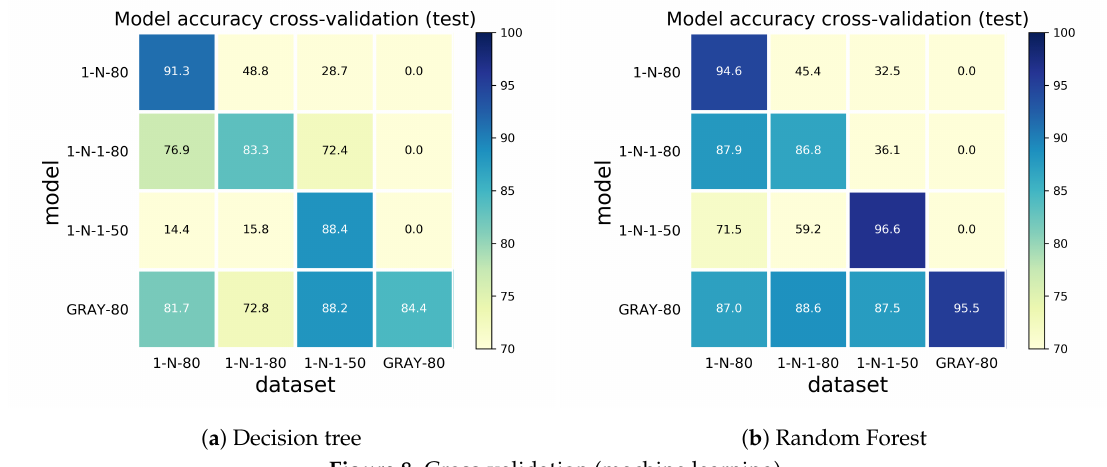
Figure 8. Cross-validation (machine learning).